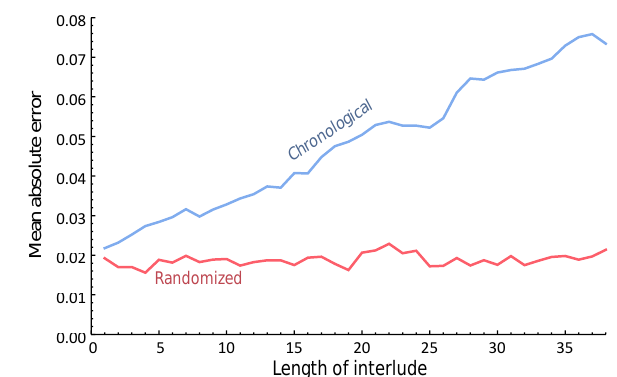
Figure 8. Values of k (table), and difference of k from 10% normal quantile vs. sample size j